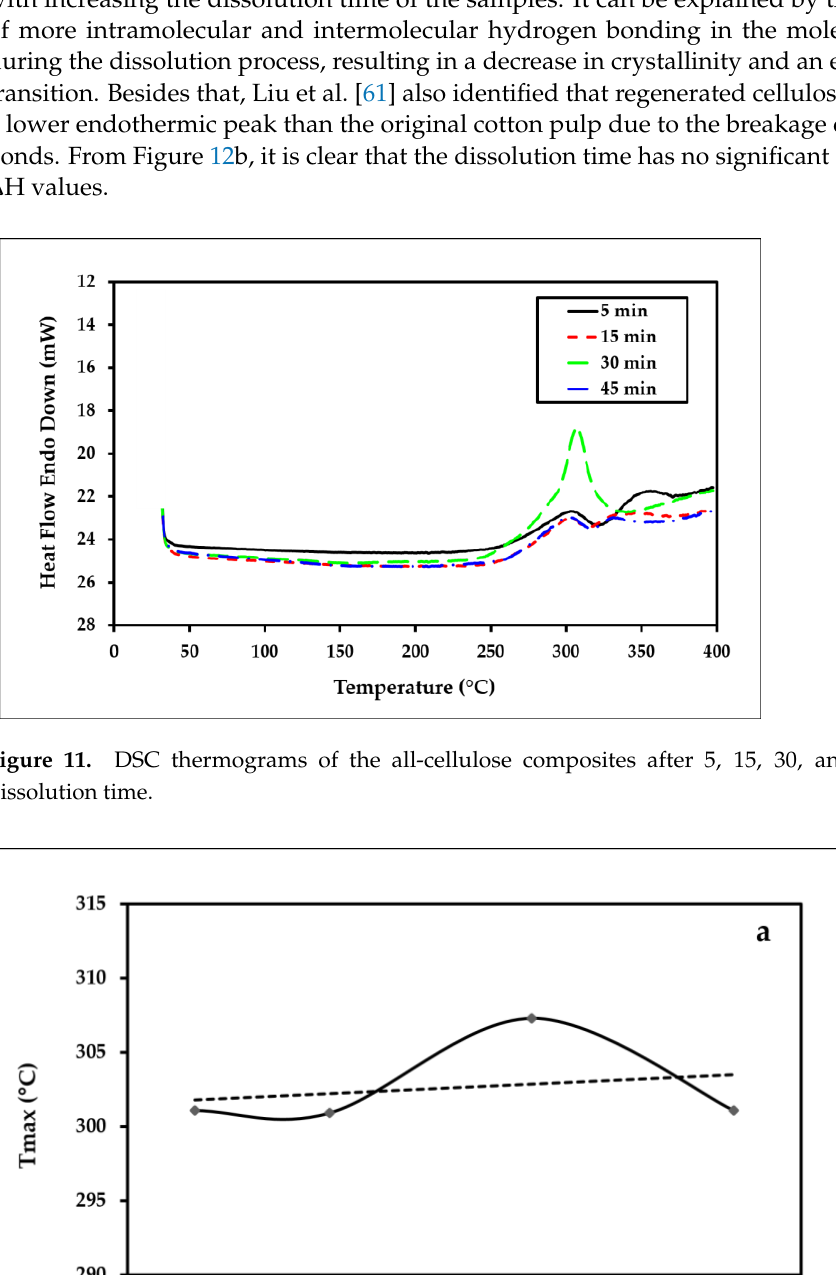
Figure 12. The variations in ( a ) T max and ( b ) ∆H versus dissolution time. Table 6. The variations in (a) T max and (b) ∆H versus dissolution time. Sample